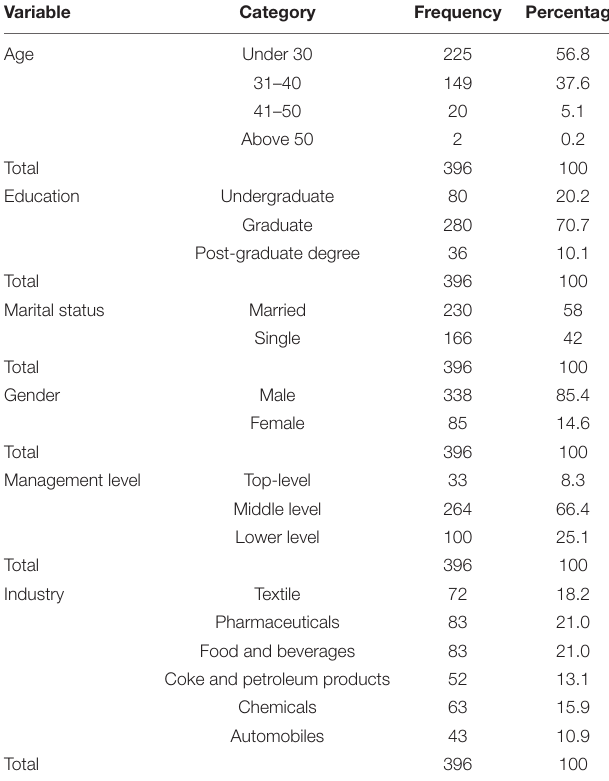
TABLE 1 | Respondent and industry